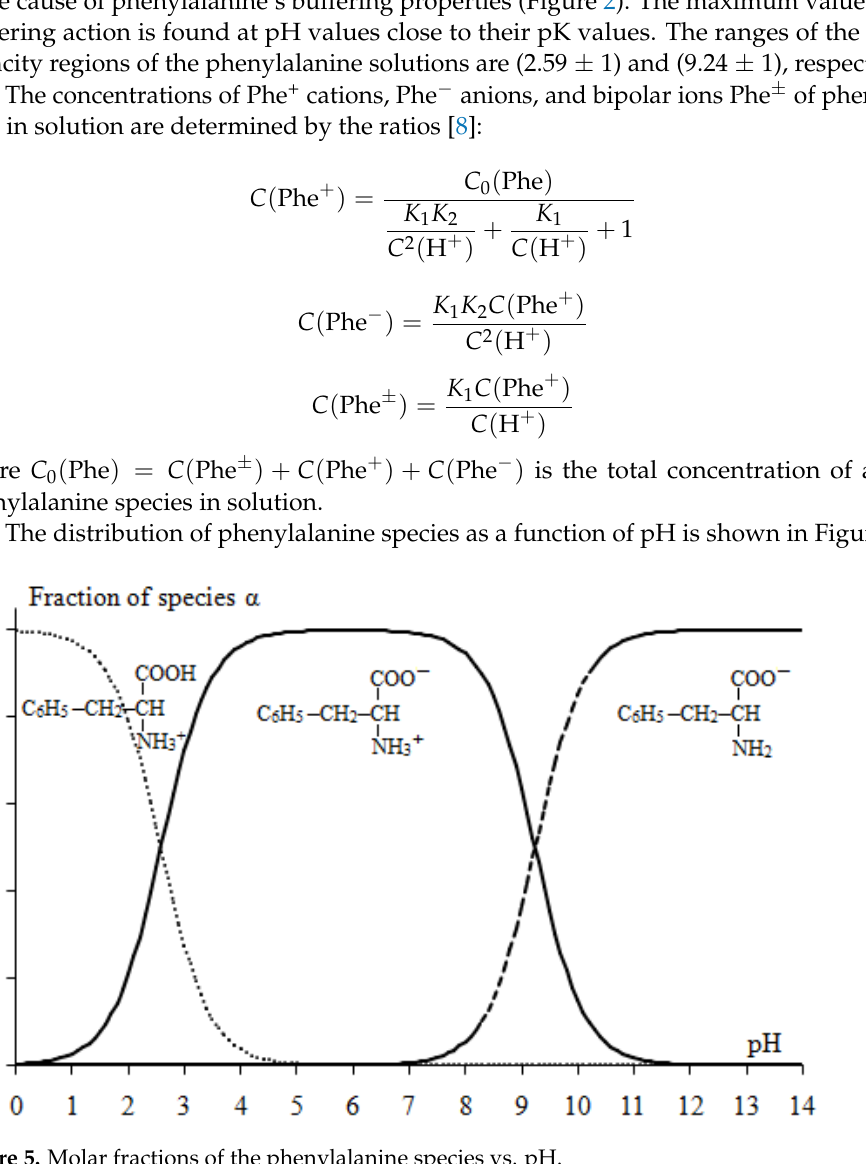
Figure 5. Molar fractions of the phenylalanine species vs pH.